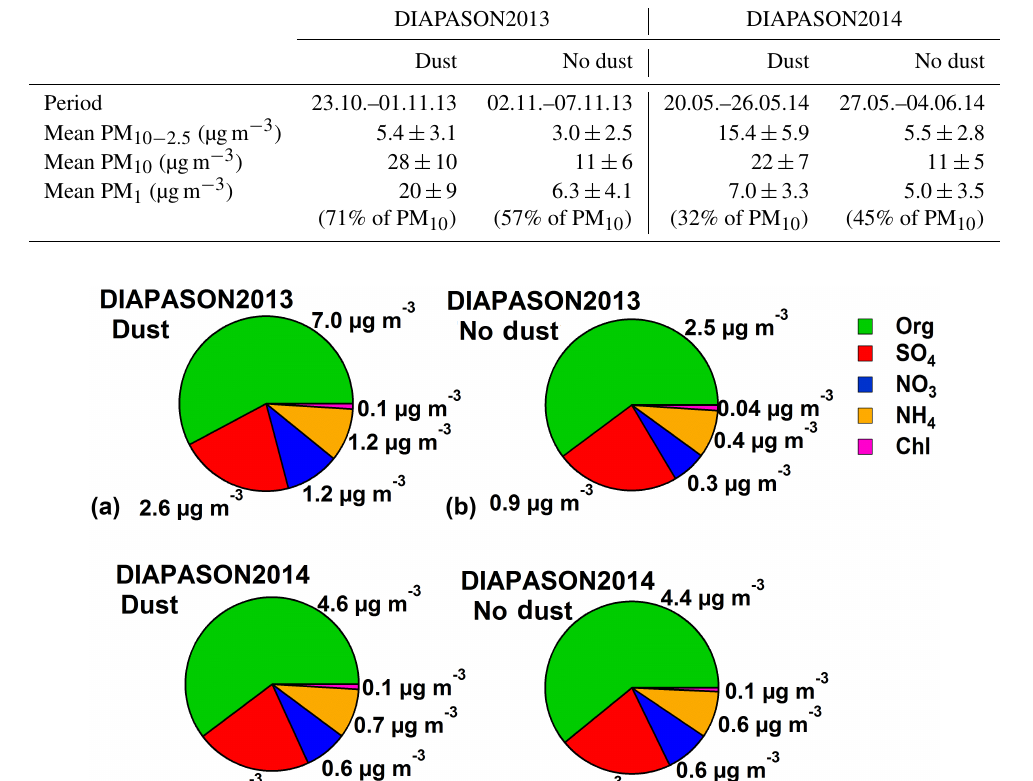
between 19 and 22 May 2014 along a cyclonic pattern, with dust originating (as in October 2013) at 30–35 ◦ N between Morocco (Saharan Atlas) and SW Tunisia (Erg